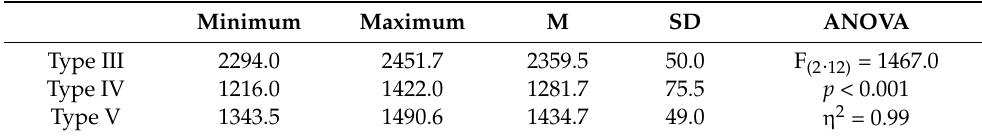
Table 4. Comparison of fracture strength by fracture type.